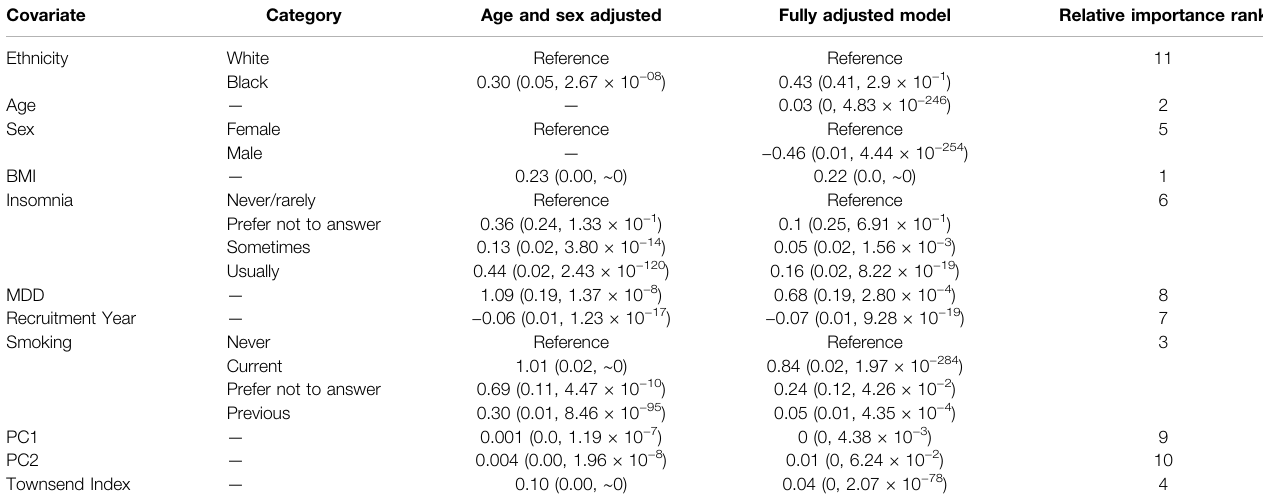
TABLE 2 | C-reactive protein multivariable linear regression models. Covariates are shown along with the category labels for categorical variables. The effect of each covariate on CRP serum levels was considered separately with age and sex adjusted models and together in the fully adjusted model. Effect point estimates are shown for each covariate along with standard errors and p -values in parentheses. The relative importance rank of each covariate in the fully adjusted model is shown.